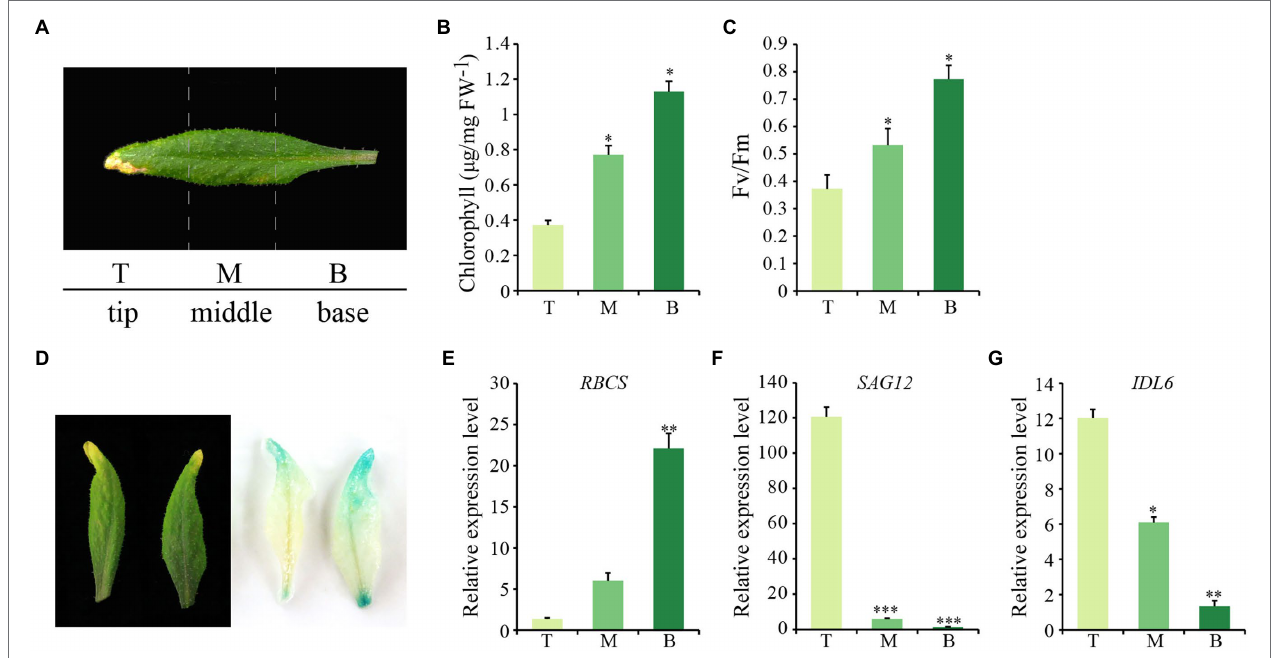
FIGURE 2 | The expression of IDL6 in different parts of a senescing leaf. (A) Representative image of three sections of Arabidopsis wild-type leaves. T: leaf tip, M: middle part, B : leaf base. Chlorophyll contents (B) and photosynthetic rates (C) in different leaf sections. (D) : GUS staining on 7th and 8th rosette leaves from 8-week-old ProIDL6 :: GUS transgenic line. (E-G) Transcript abundance of RBCS , SAG12 and IDL6 in different leaf sections. The data are means ± SD of three biological repeats. Significant differences compared with the tip part were determined by Student’s t -test (* p < 0.05, ** p < 0.01, and *** p <